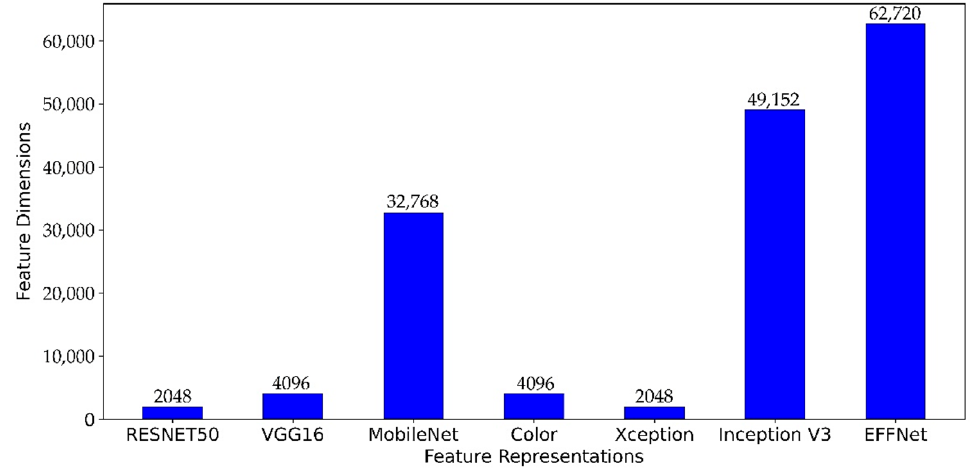
Figure 7. The vector size of the feature presentation (Conv1D).